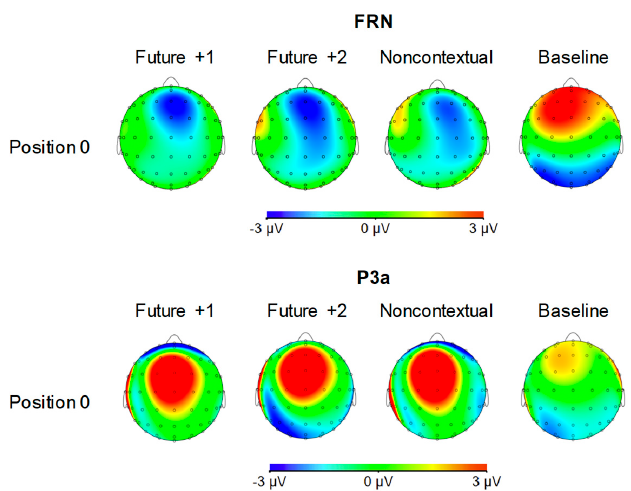
Figure 6. Voltage (in µ V) scalp topographies of feedback-related negativity (FRN) and P3a components elicited by pitches at target event position 0 by feedback condition. Activity averaged over 40 ms surrounding each component’s grand average peak is shown.